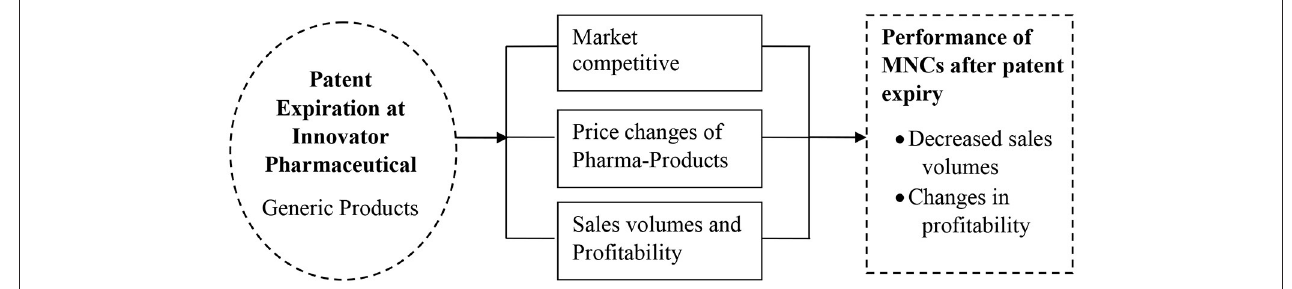
FIGURE 1 | The conceptual